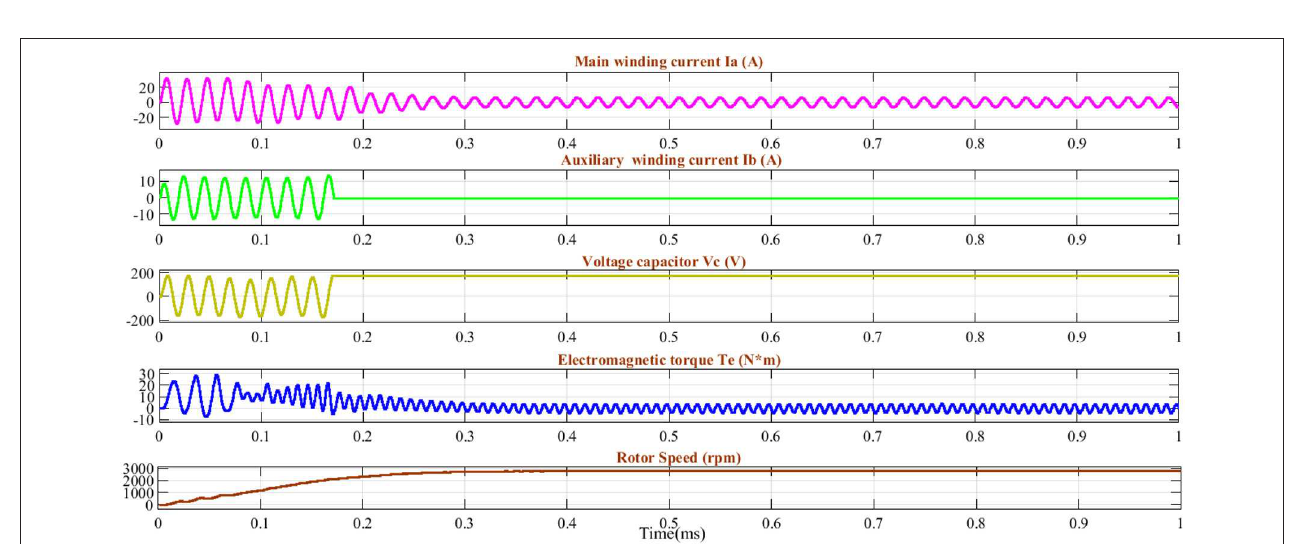
FIGURE 11 | Dynamic performance of single-phase induction motor fed by seven-level inverter with five switches.